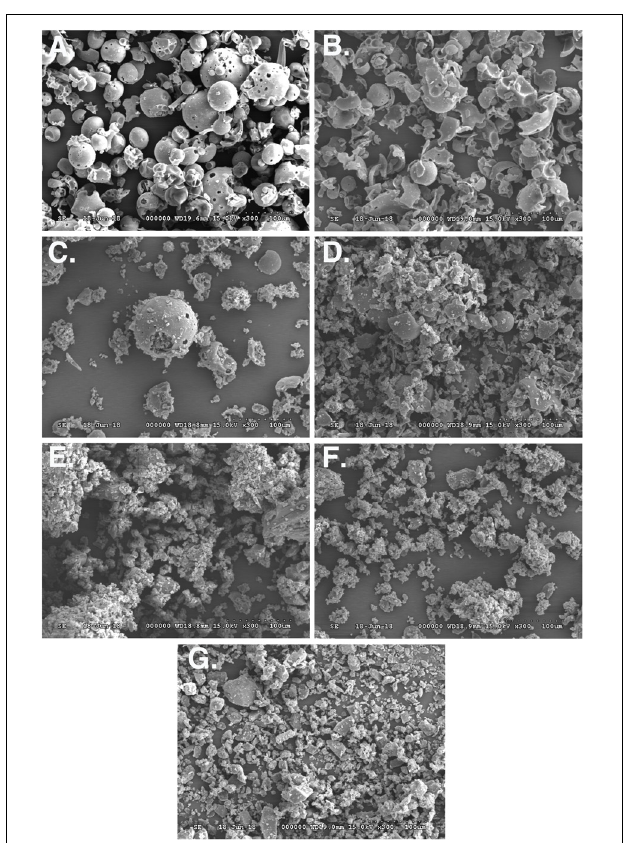
FIGURE 3 | Scanning electron microscopy (SEM) images of HPBCD (A) , RAMEB (B) , silymarin-HPBCD physical mixture (C) , silymarin-RAMEB physical mixture (D) , silymarin-HPBCD complex (E) , silymarin-RAMEB complex (F) , free silymarin (G)